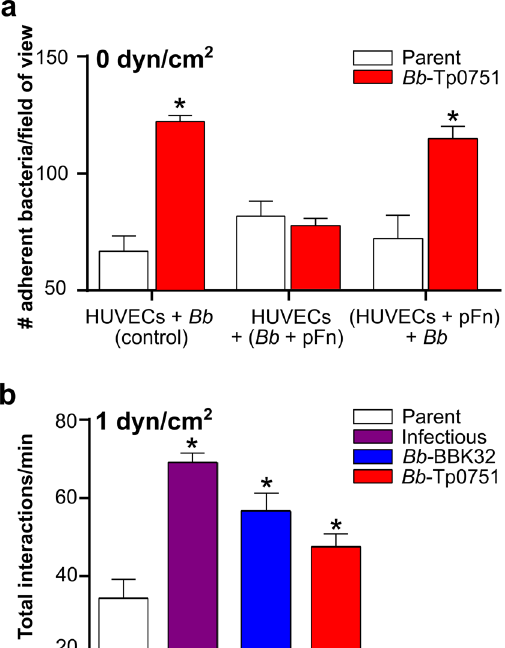
Figure 1. Interaction of Tp0751-expressing strains with human endothelia under static and shear stress conditions. ( a ) Mean ± SEM numbers of parent and Tp0751-expressing B . burgdorferi ( Bb -Tp0751) adhered to primary human umbilical vein endothelial cell (HUVEC) monolayers after 12 h of co-incubation under static (0 dyn/cm 2 ) conditions (HUVECs + Bb , control). HUVECs + ( Bb + pFn): binding of bacteria pre-incubated with plasma fibronectin (pFn) to HUVECs. (HUVECs + pFn) + Bb : binding of bacteria to HUVEC pre- incubated with pFn. N = 3 independent bacterial and endothelial cultures/strain analyzed in 2 experiments. ( b ) Mean ± SEM bacterial interactions per minute with HUVEC under typical postcapillary venule shear stress condition (1 dyn/cm 2 ). Videos of representative flow chamber experiments are presented in